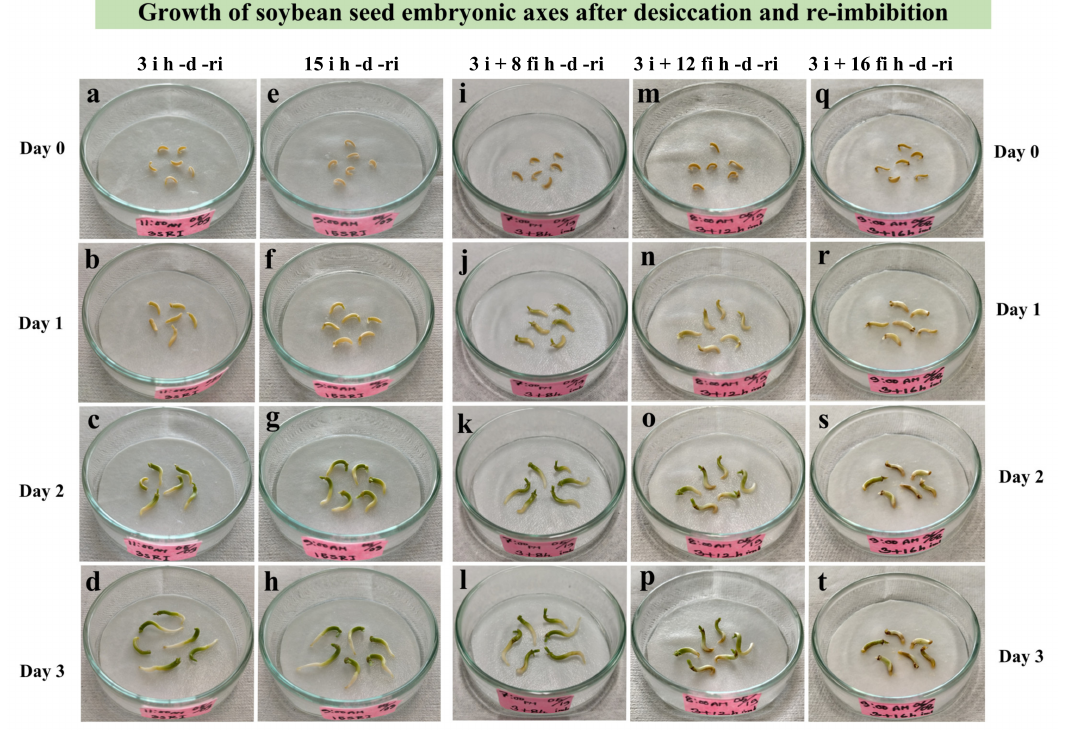
Figure 3. Growth of soybean embryonic axes during 3 days after re-imbibition ( ri ) following 24 h desiccation ( d ). Embryonic axes were excised after 3 h ( a – d ), and 15 h ( e – h ) imbibition ( i ) of seeds or kept on wet filter paper ( fi ) for an extra 8 h ( i – l ), 12 h ( m – p ), or 16 h ( q – t ) after excision from 3 h imbibed ( i ) seeds. The growth of embryonic axes, especially radicles, was significantly retarded in the samples with long additional incubation on wet filter paper after excision from imbibed seeds ( p , s , t